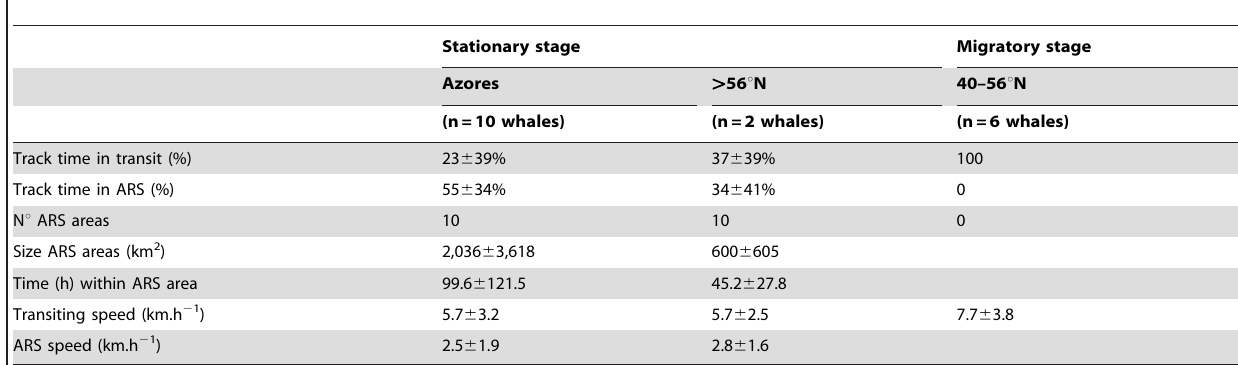
Table 3. Fin whale movements and behaviour at different stages along the migratory path.